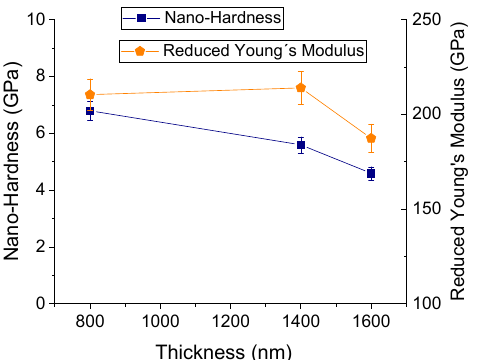
Figure 13. Hardness and reduced modulus of elasticity of the Cr coatings deposited on Si.